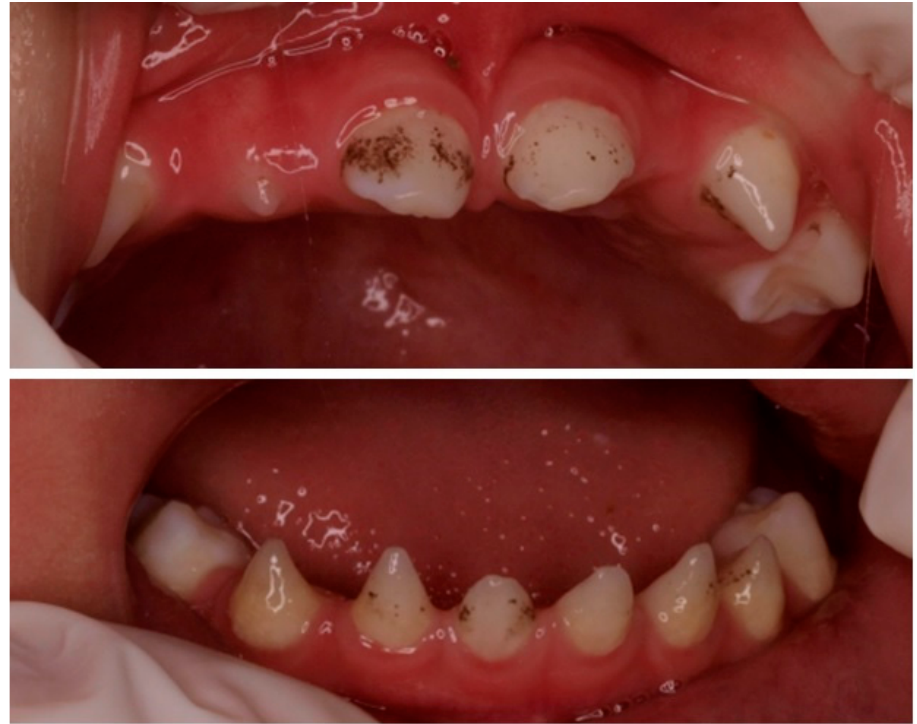
Figure 1. Presence of conical anterior temporary teeth. Absence of the left lateral maxillary incisor and the maxillary and mandibular second molars.